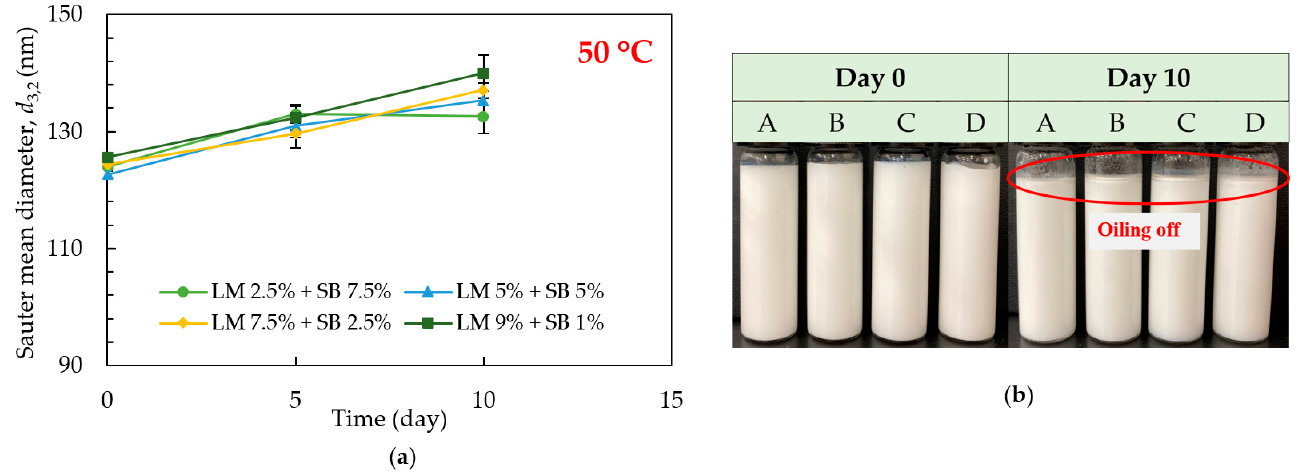
Figure 5. E ff ect of storage time, temperature, and SB concentration on the physical stability of the emulsions loaded with LM during 10 days of storage at 50 °C. ( a ) Sauter mean diameter ( d 3,2 ) and ( b ) The photos of the emulsions on days 0 and 10 where A: LM 2.5% + SB 7.5%, B: LM 5% + SB 5%, C: LM 7.5% + SB 2.5%, and D: LM 9% + SB 1%.